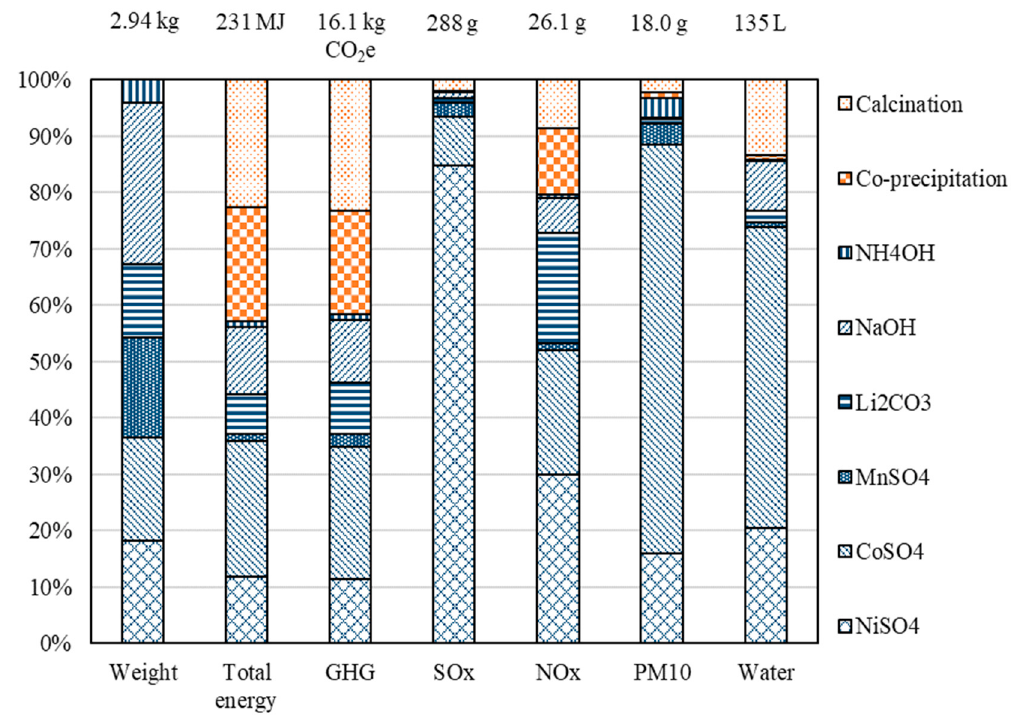
Figure3. Energyandenvironmentalimpactbreakdownsof1kgNMC111powder. Bluedenotesmaterial inputs; orange denotes energy inputs and non-combustion emissions for NMC111 powder